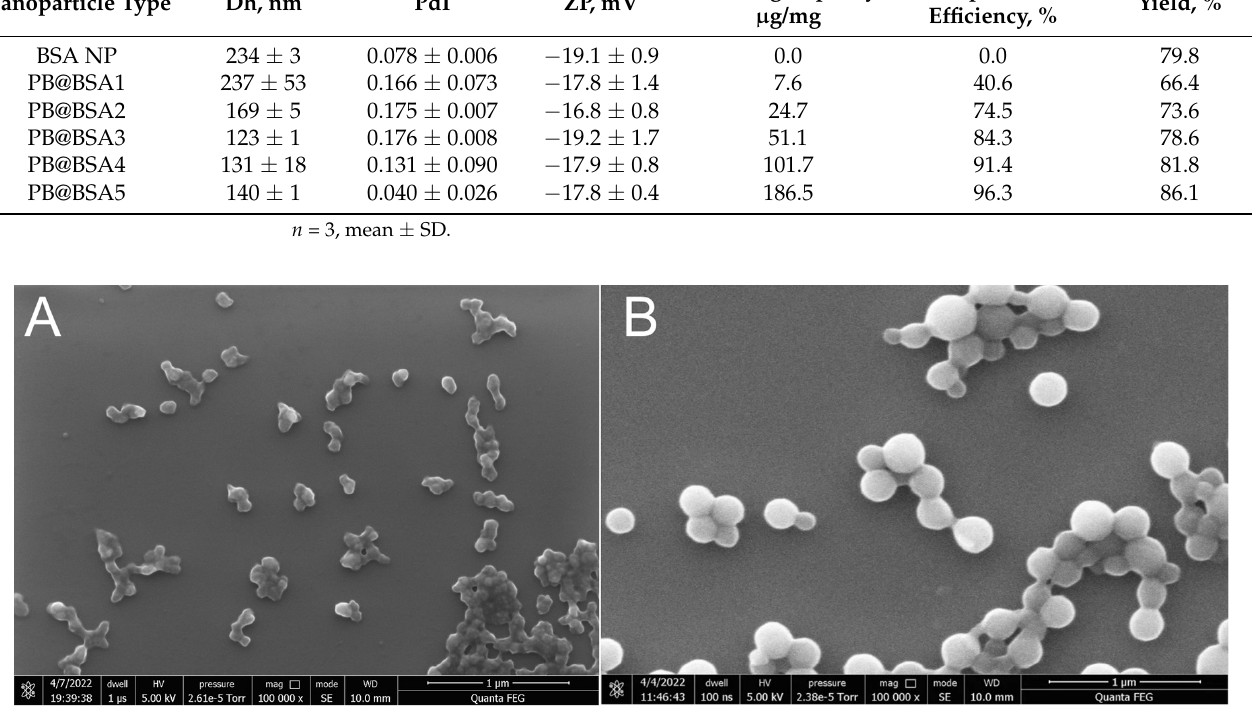
Figure 2. SEM images of PB@BSA5 ( A ) and BSA NP ( B ) nanoparticles. Scale bars—1 μ m. Table 1. Properties of PB@BSA nanoparticles.